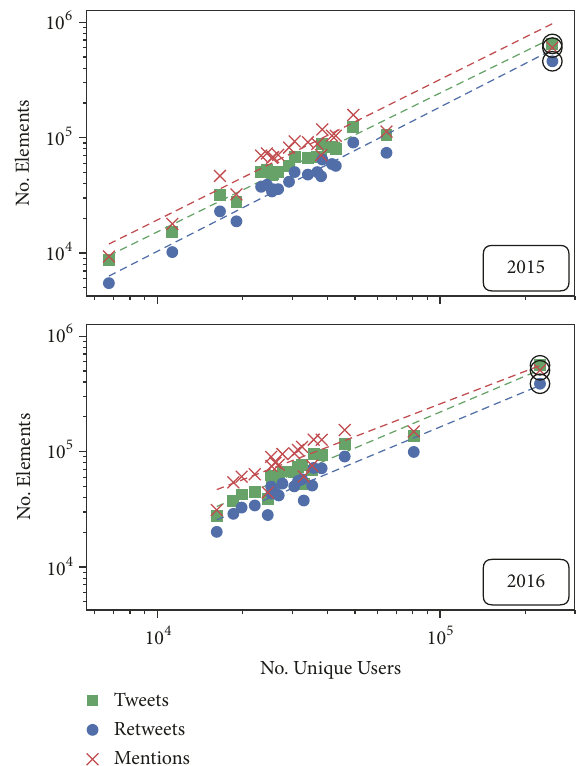
election was slightly lower than in 2015, the slope of the linear regression is lower than 1.